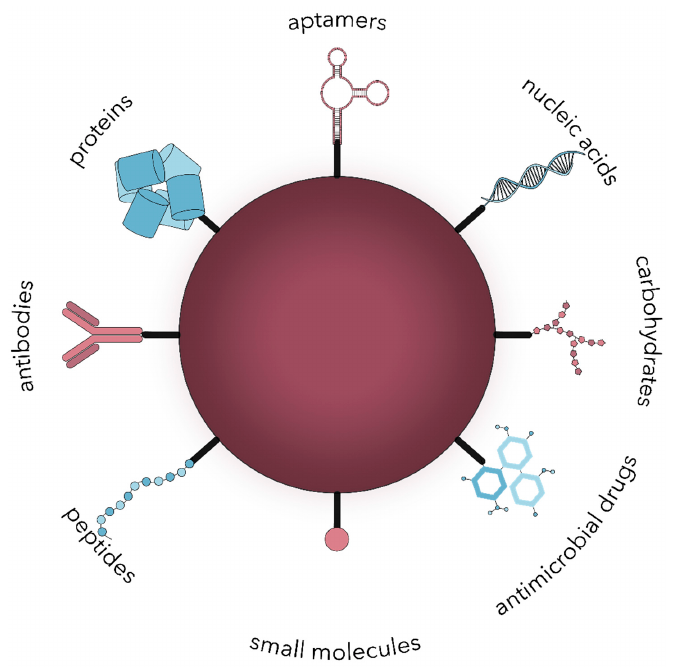
Figure 2. The main types of biomolecules used for the surface modification of nanoparticles for active microbial